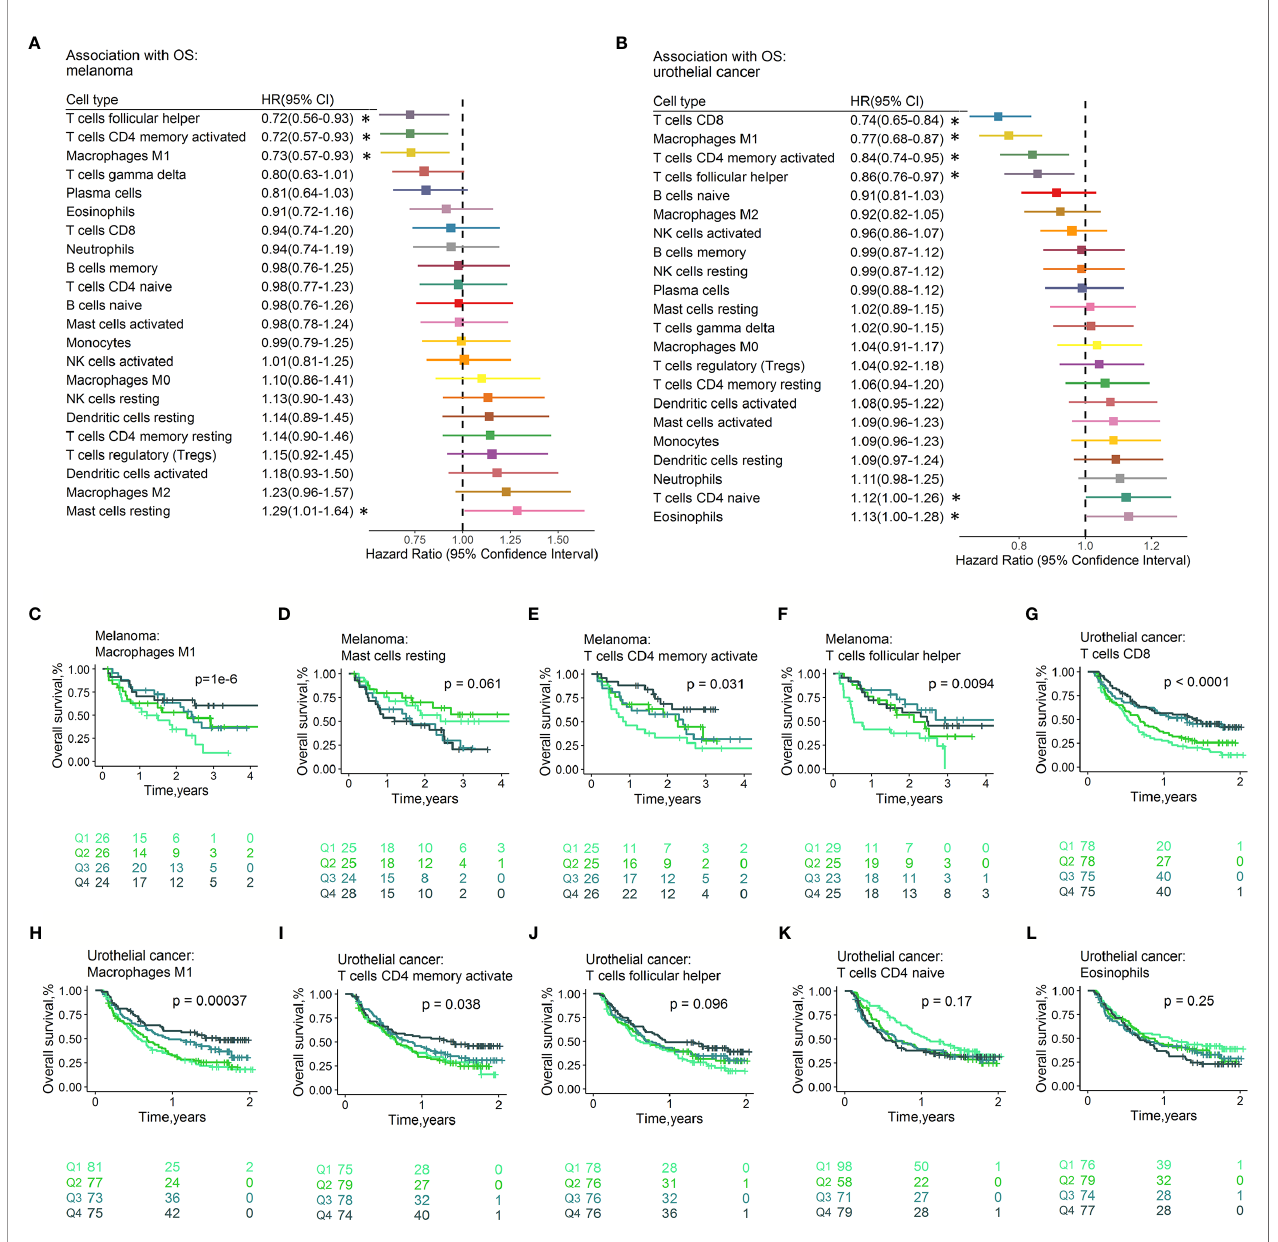
FIGURE 6 | Associations between OS and immune cell subtypes. Forest plot demonstrating HRs (boxes) and 95% CIs (horizontal lines) for the association with PFS after ICI therapy in melanoma (A) and urothelial cancer (B) . The results were obtained from univariate Cox regression analysis. The size of the box is negatively proportional to the standard error of the HR. * denote HRs with a p-value < 0.05. Survival curves of quartiles of immune cell fractions (C – L) . Illustrated p-values are from log-rank tests. HR: hazard ratio. PFS, Progression-free survival; CI, con fi dence